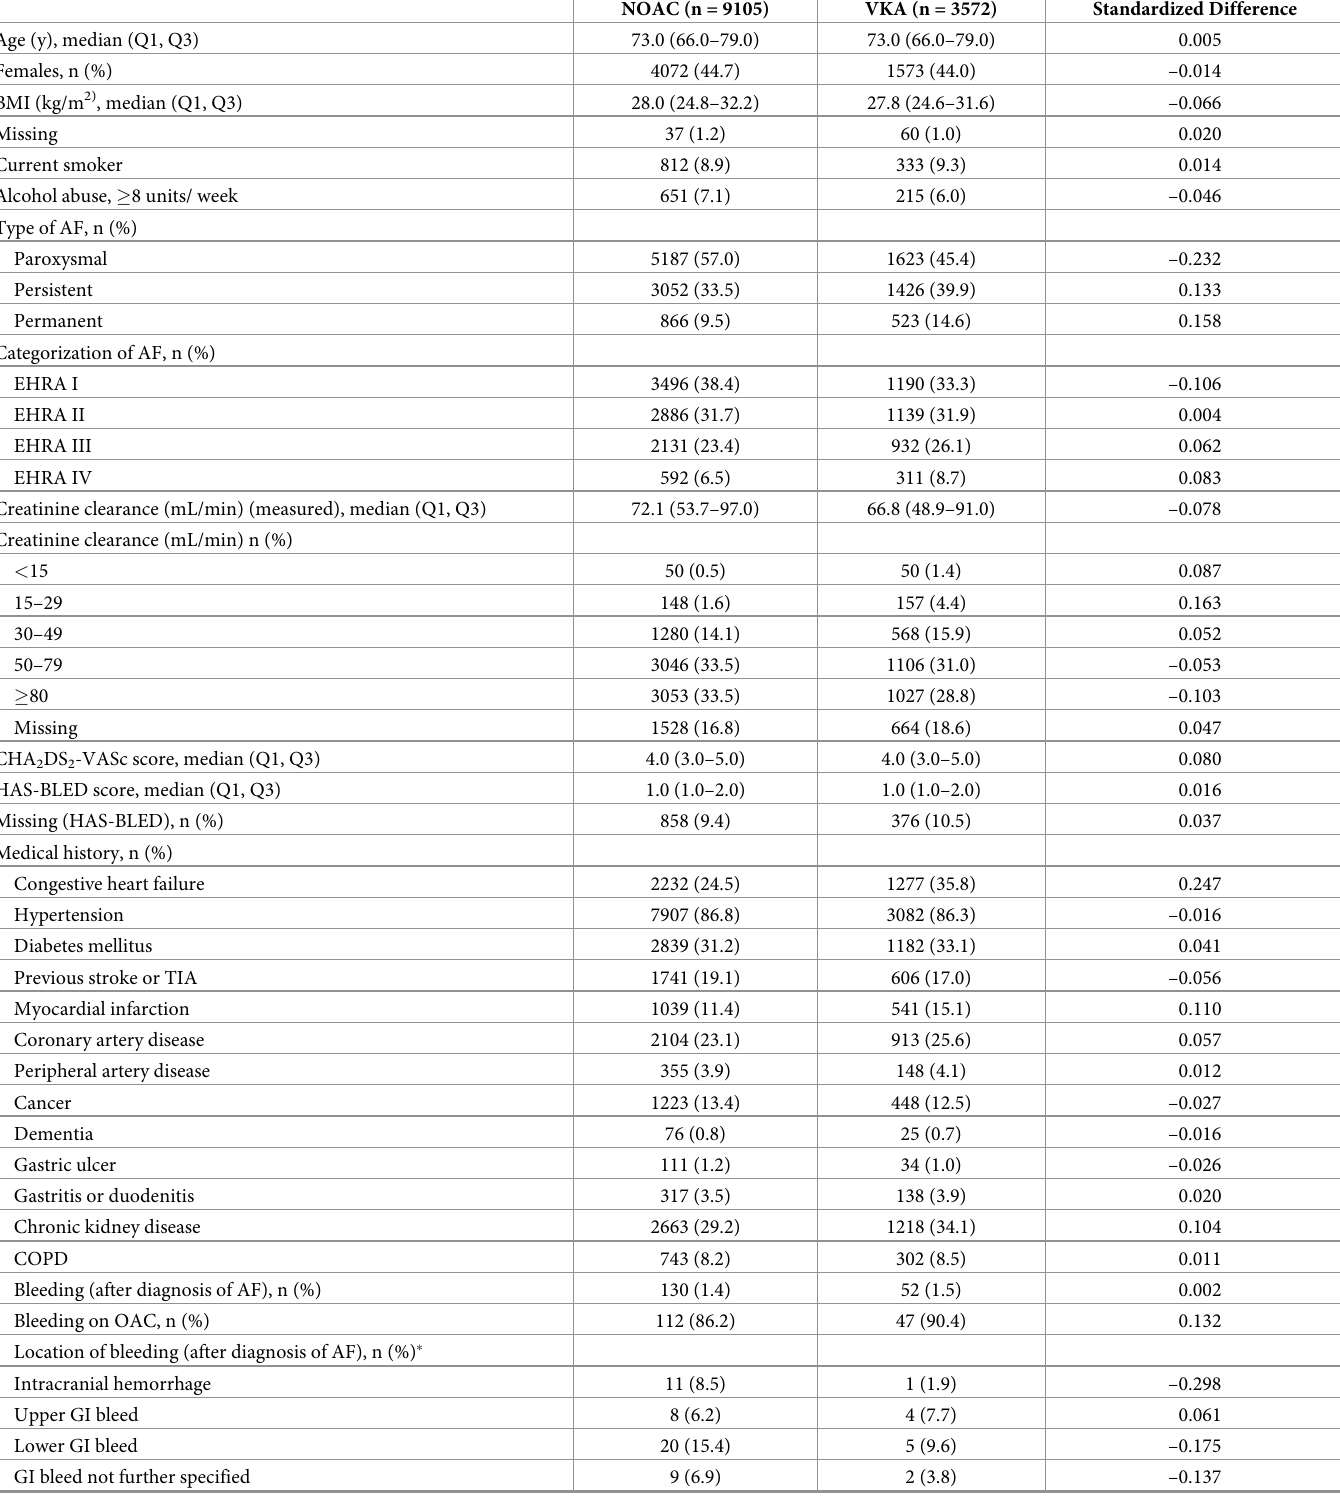
Table 3. Baseline characteristics of AF multimorbid patients prescribed NOACs or VKAs a